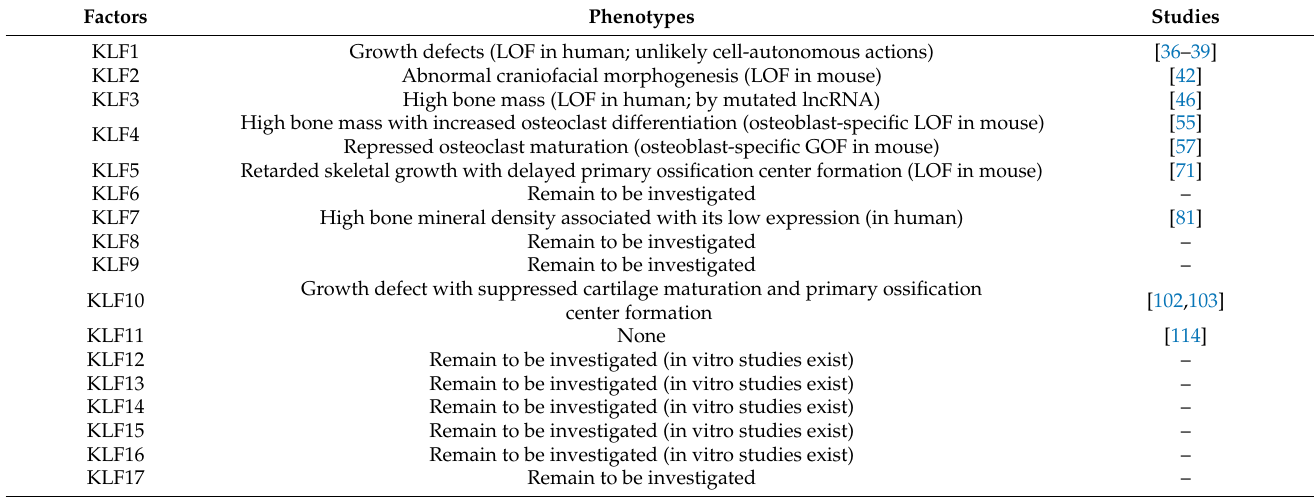
Table 1. In vivo skeletal phenotypes caused by loss (LOF) or gain (GOF) of function of